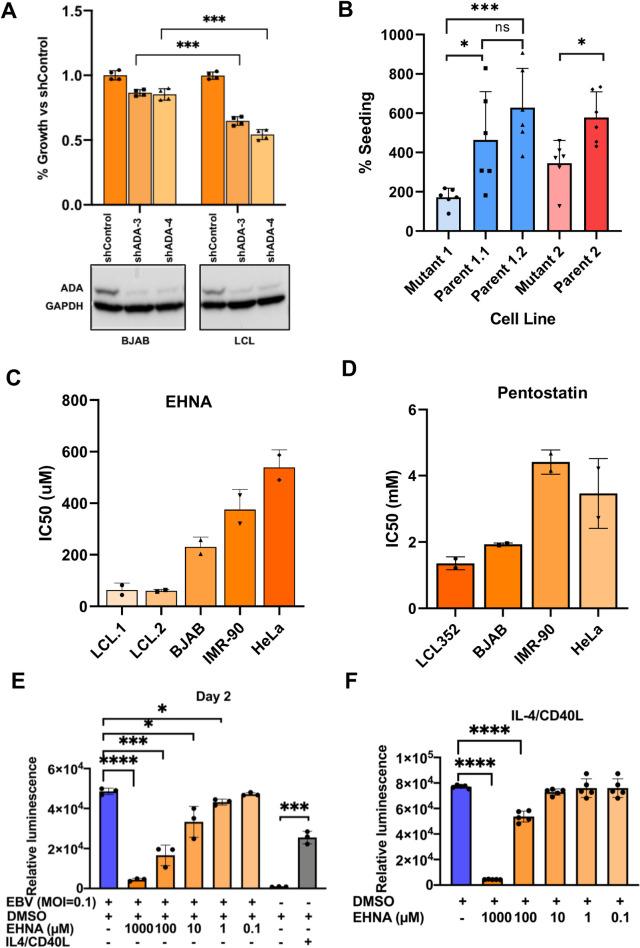
Requirement for ADA activation during EBV immortalization.(A) ADA expression was knocked down by transduction with lentivirus shRNA in EBV- BJAB or LCL cells. Relative proliferation was determined by CellTiter-Glo assay and normalized to shControl-transduced cells. Western blot for ADA and loading control GAPDH (lower panel). (B) Reseeding efficiency was compared between LCLs from ADA-associated SCID patients and their phenotypically normal parents (*, p<0.05; **, p<0.01; ***, p<0.001; ns, not significant; p values determined by two-tailed t-test; data represents a minimum of 3 independent experiments). (C) EBV+ and EBV- cell lines were treated with serial dilutions of the ADA inhibitor, EHNA, for 72hrs and the IC50 value for each cell line was determined. Data represents two independent experiments with 3 technical replicates per experiment. (D) Same as in panel C, except using Pentostatin as ADA inhibitor. (E) Primary B-cells infected with EBV in the absence (blue bar) or presence of increasing concentrations of EHNA and assayed at day 2 for ATP levels by CellTiterGlo. In parallel, primary B-cells were treated without or with IL-4/CD40L and assayed with CellTiterGlo. (F) Primary B-cells treated with IL-4/CD40L in the absence or presence of increasing concentrations of EHNA and assayed for ATP levels by CellTiterGlo. *, p<0.05; ***, p<0.001; ****, p < .0001; p values determined by two-tailed t-test; data represents a minimum of 3 independent experiments.